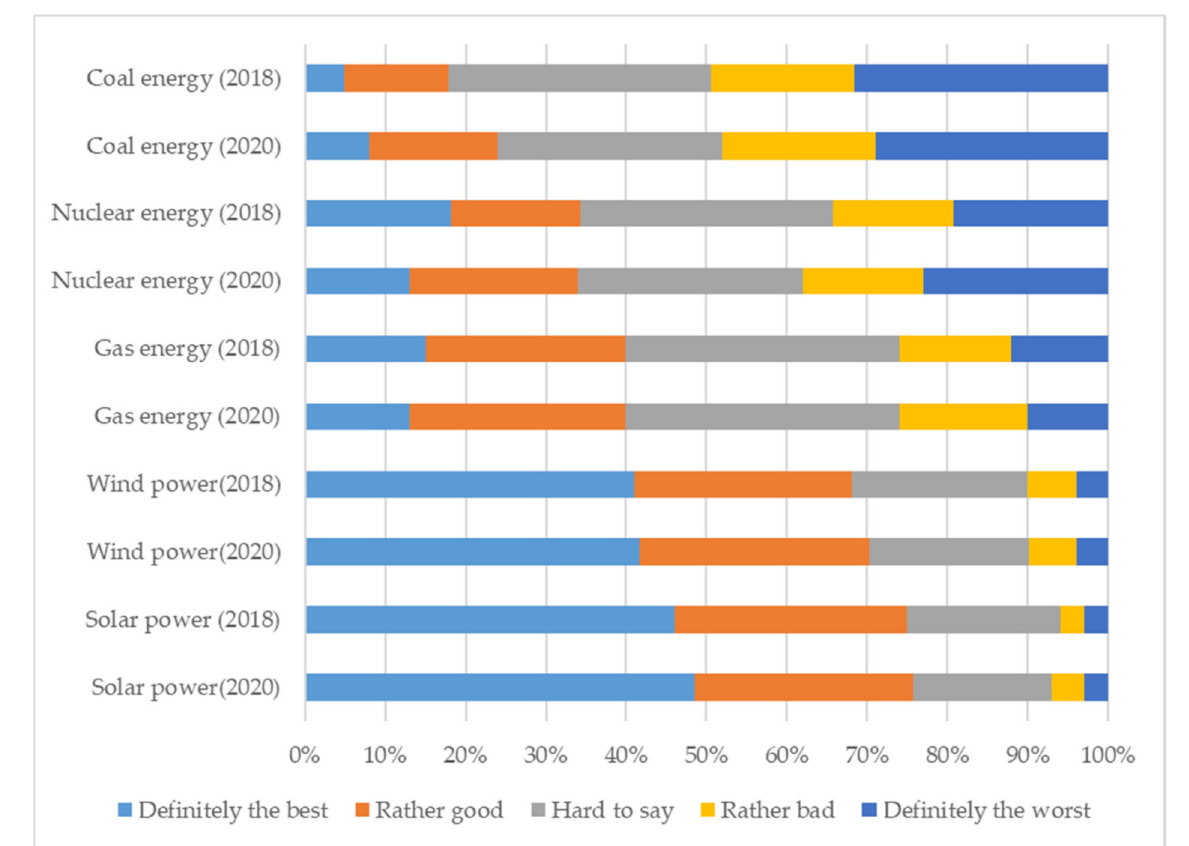
Figure 7. Comparative assessment of the different methods of power generation. Source: developed by the authors, based on References